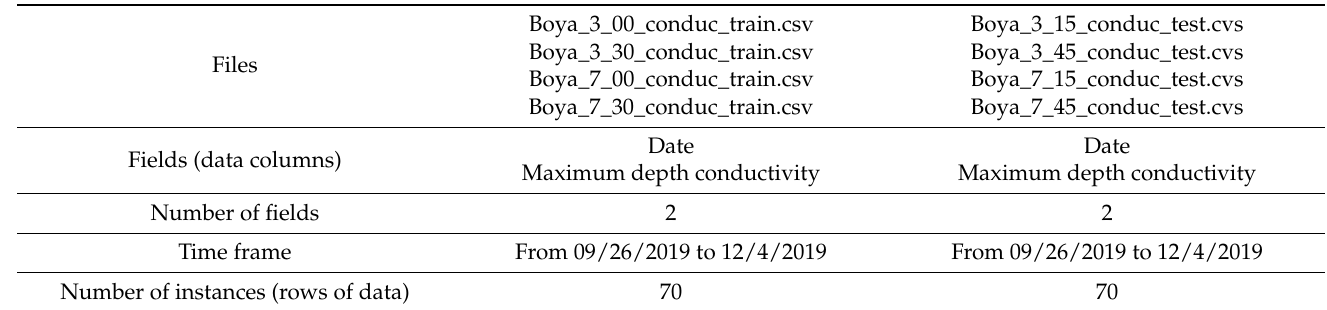
Table 4. Dataset Structure.